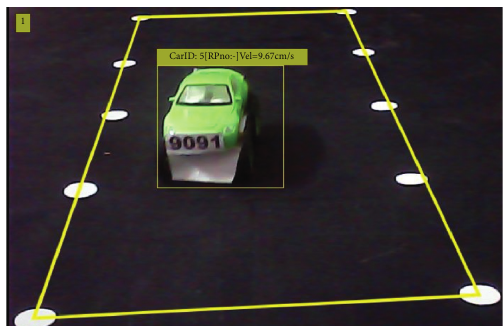
Figure 22: Frame showing the car being tracked on the experi- mental setup with ID 5 and monitoring its speed.